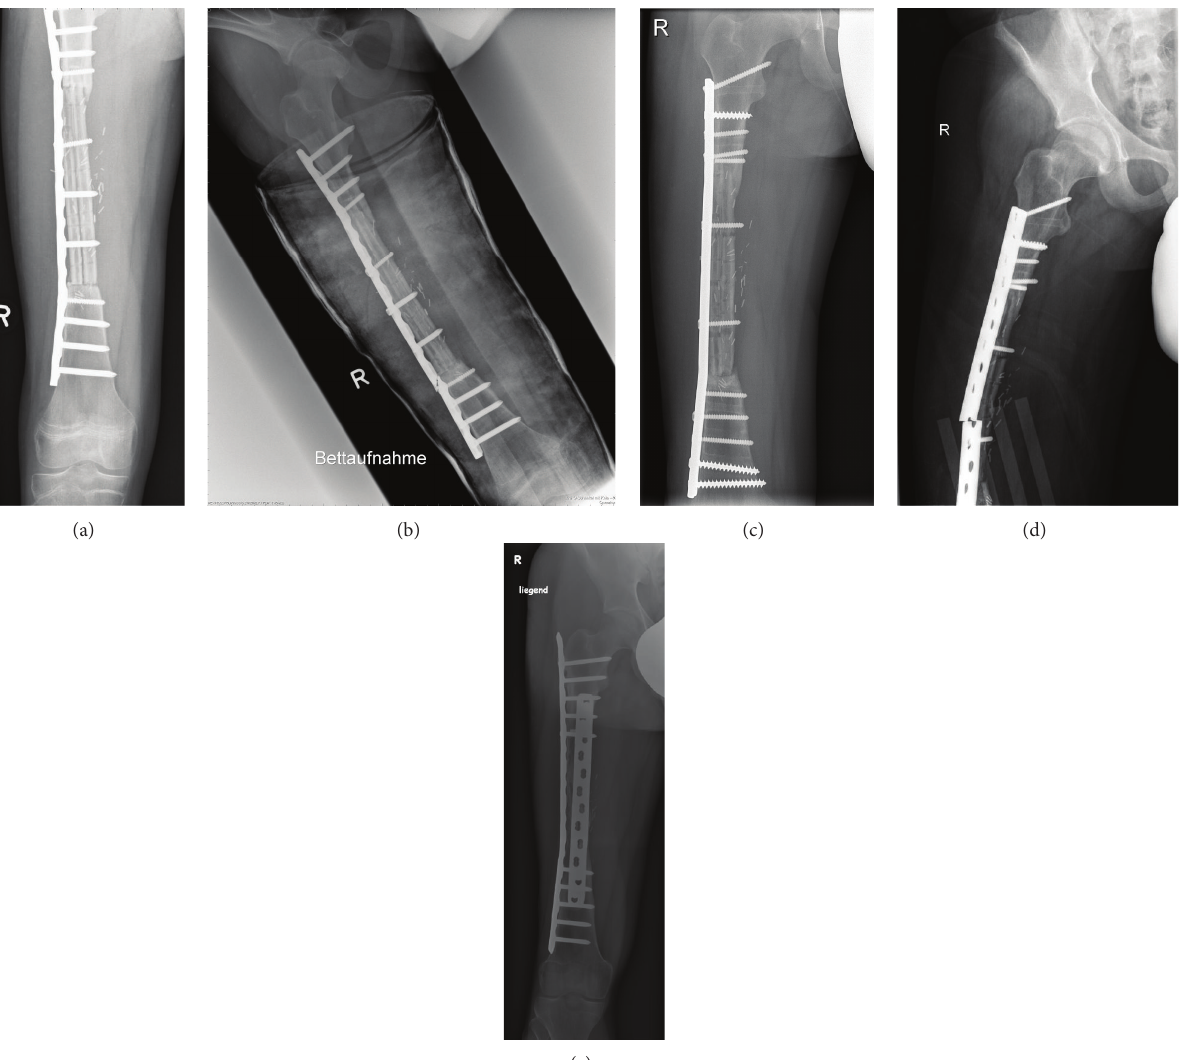
Figure 3: (Patient no. 8) (a) 12-year-old boy with Ewing’s sarcoma of the right femur diaphysis. Radiograph showing the reconstructive result with a bilateral free fibular graft and lateral plate fixation for a defect of 16,5cm. (b) 15 months after tumor resection plate failure occurred at the distal interphase between fibular graft and femur metaphysis showing an osseous nonunion. The patient had received his neoadjuvant and adjuvant chemotherapy according to EURO-E.W.I.N.G.-99-protocol including adjuvant radiotherapy. (c) The fracture was treated with replatingandautogenousbonegrafting.(d)5monthslaterasecondplatefractureoccurredinthemiddleofthefibulargrafts.Thefibulargrafts themselvesshowedtwofracturesondifferentlevels.Thebonystructuresshowsignsofdemineralizationandirregularitiesduetoadministered chemo- and radiotherapy. (e) Surgical revision resulting in double plate osteosynthesis and autogenous bone grafting. So far there have been no more complications until the last follow-up at 62